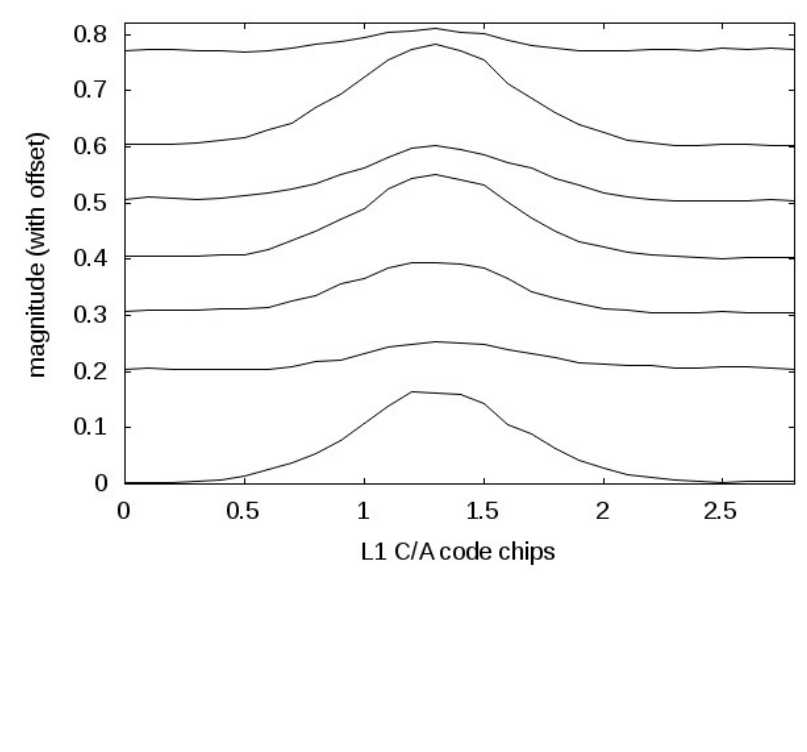
Figure 10. February 4th delay waveforms at consecutive seconds (1 seconds slices of the 3-D image in Figure 9). The waveforms are arbitrarily offset for clarity, where second 0 is plotted at the lowest offset and subsequent seconds are plotted with increasing offsets.